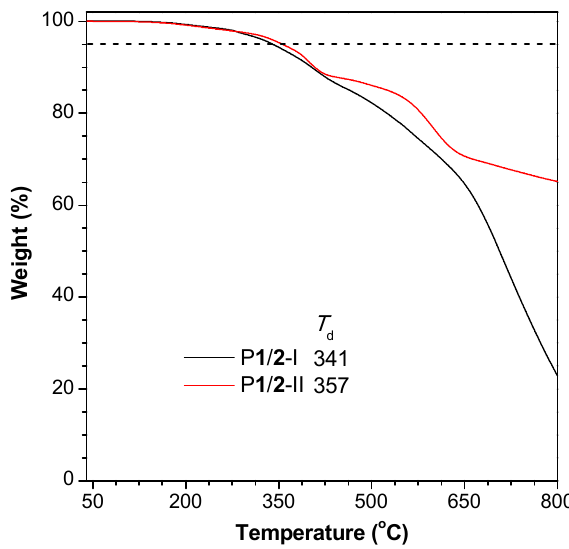
Figure 3. TGA thermograms of P 1 / 2 -I and P 1 / 2 -II recorded under nitrogen at a heating rate of 10 °C/min. T d represents the degradation temperature for 5% weight loss. 10 ◦ C/min. T d represents the degradation temperature for 5% weight